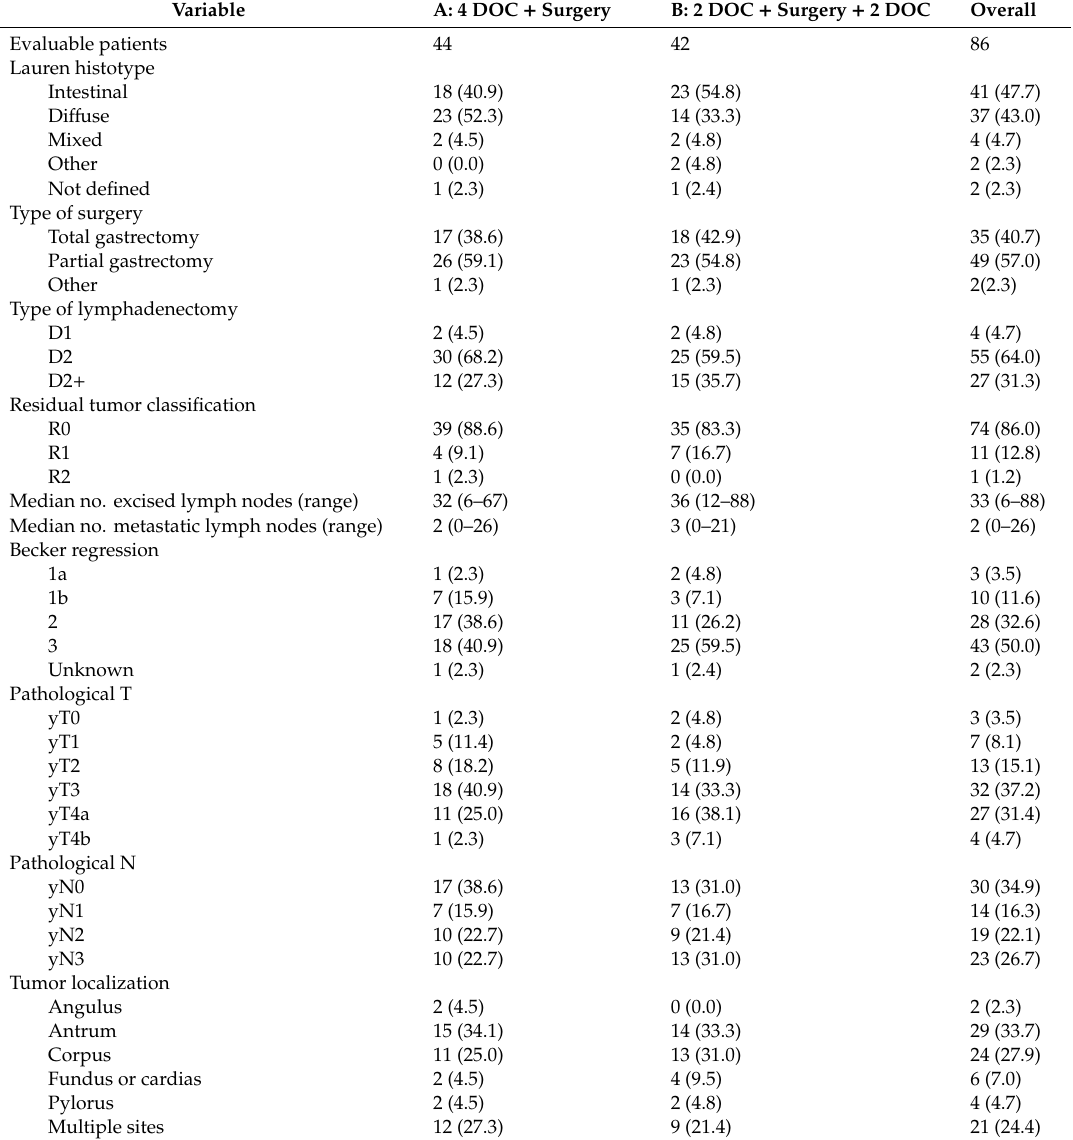
Table 5. Characteristics of surgical intervention by treatment